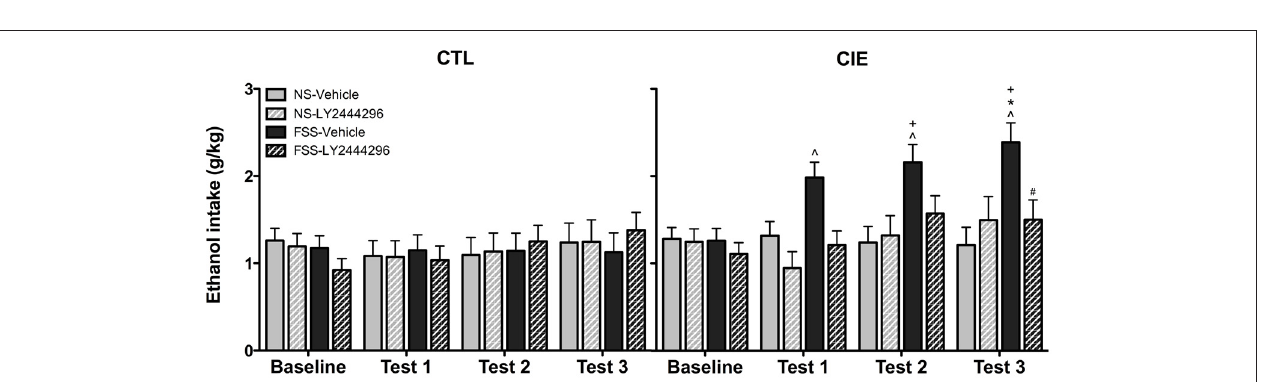
FIGURE 2 | Average weekly ethanol consumption (g/kg). Among air-exposed control (CTL) mice, administration of the KOR agonist U50,488 (5 mg/kg) resulted in elevated ethanol intake relative to baseline (indicated by ∧ ), non-stressed (NS) mice (indicated by ∗ ), and forced swim stress-exposed (FSS) mice (indicated by + ) during all three test weeks. Among mice exposed to chronic intermittent ethanol (CIE), administration of U50,488 resulted in elevated ethanol intake relative to baseline (indicated by ∧ ) and non-stressed mice (indicated by ∗ ) during Tests 1–3, and relative to FSS mice during Test 3 (indicated by + ). FSS mice demonstrated elevated ethanol consumption relative to baseline during all three test weeks (indicated by ∧ ).